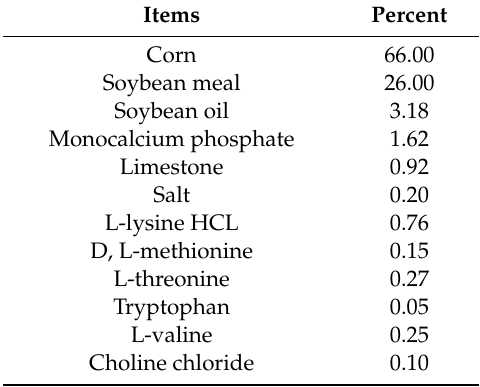
Table 3. Composition of the basal diet in experimental 2 (as-fed